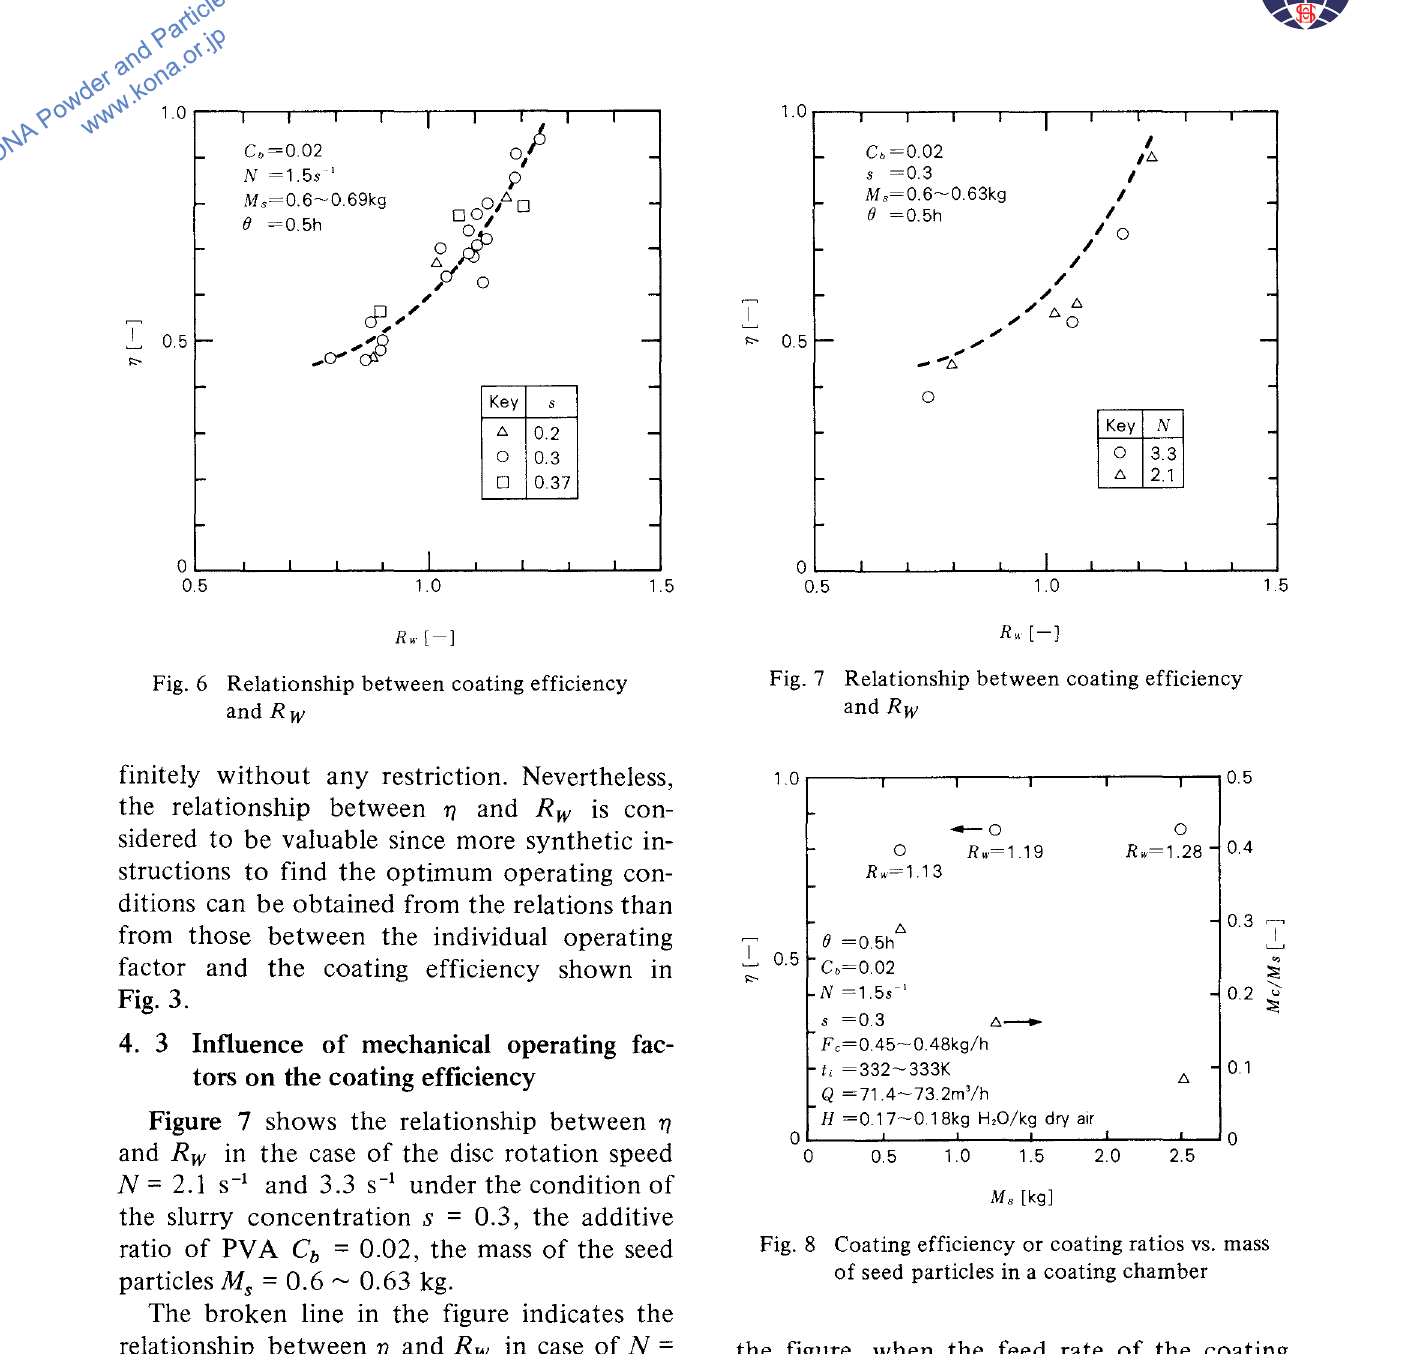
Fig. 6 Relationship between coating efficiency andRw